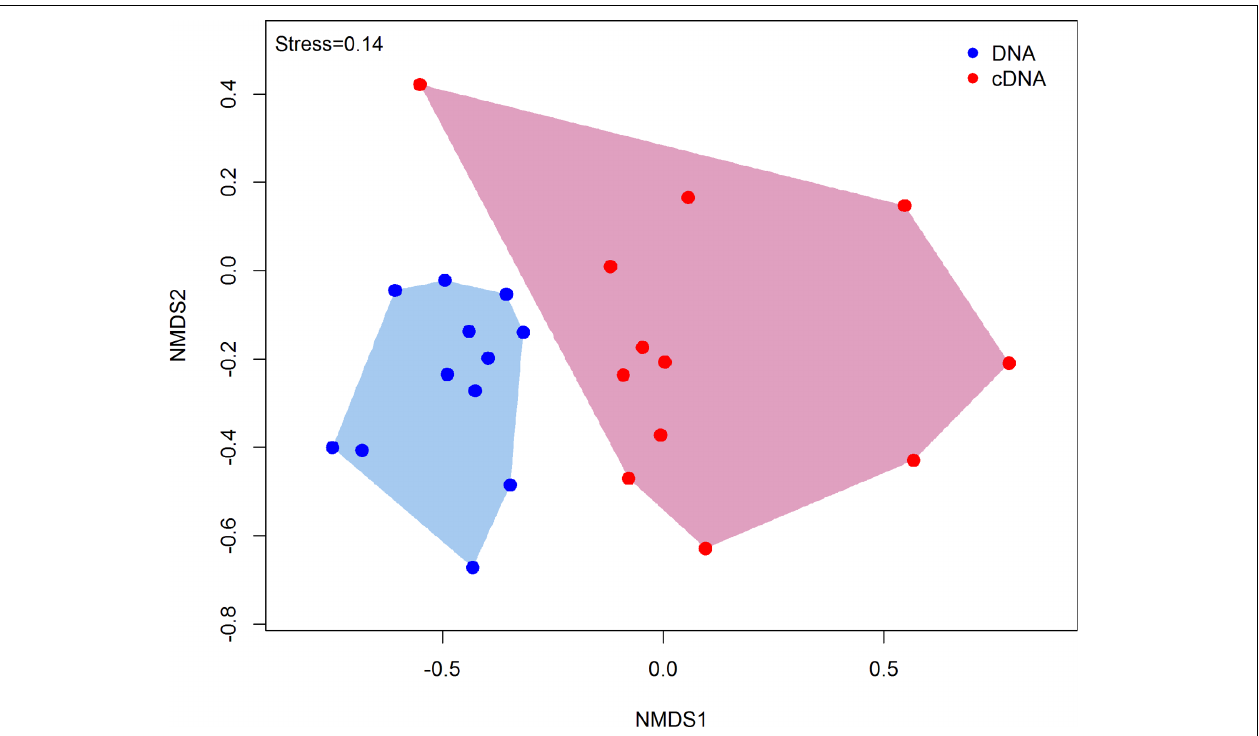
FIGURE 1 | Non-metric multidimensional scaling (nMDS) ordination plot (Bray–Curtis dissimilarities) comparing the structures of total and potentially active hypolith communities. Each point within the ordination represents an entire microbial community (sample). Total hypolith communities are shown as blue circles while potentially active communities are indicated by red circles. Different shaded areas depict different bacterial communities (PERMANOVA, P < 0.05).